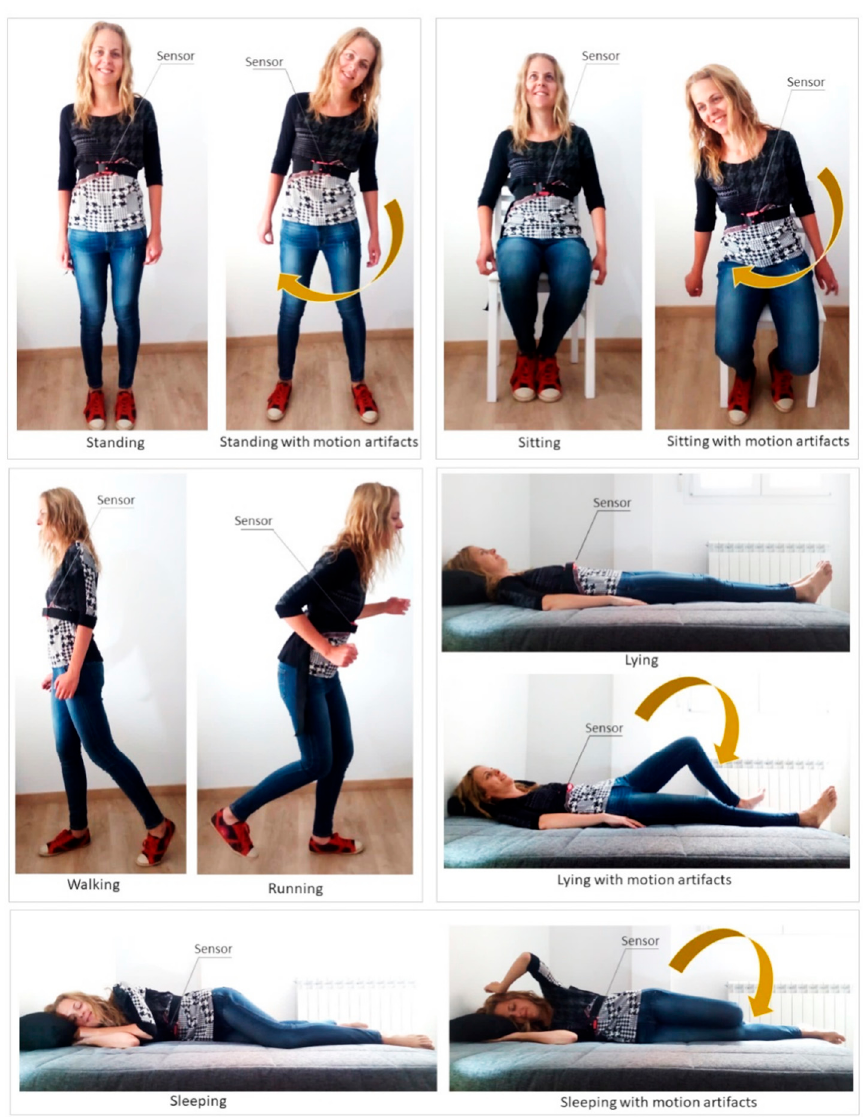
Figure 24. Common positions / activities to validate the breathing sensors (sitting, standing, lying down, walking, running, and sleeping). Chest sensor used as an example.